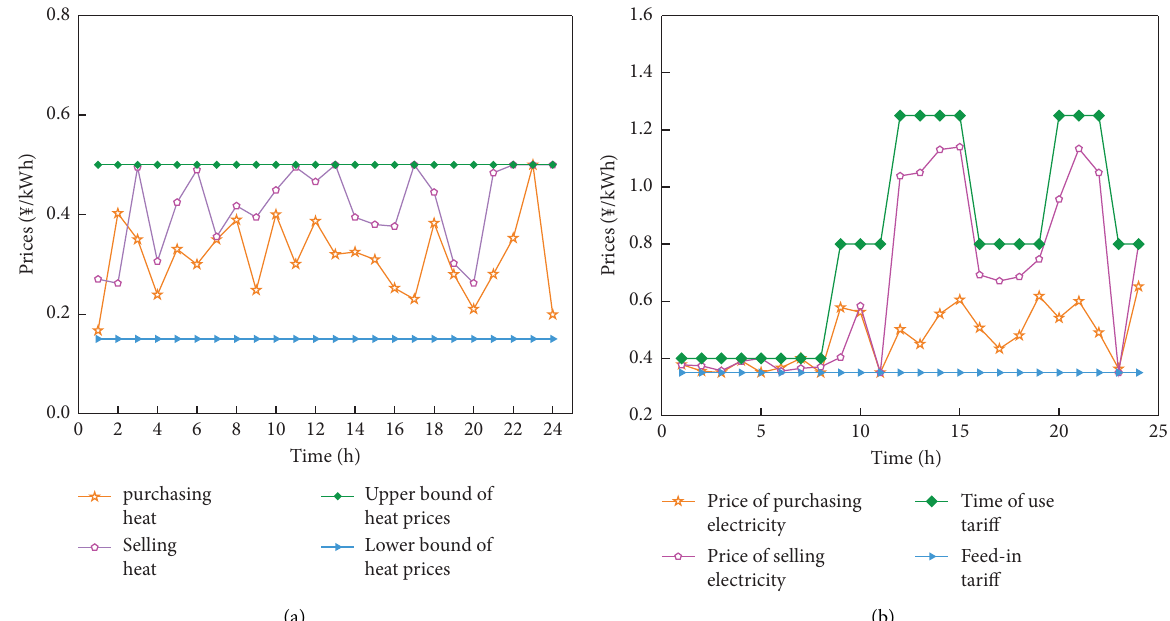
Figure 9: Energy prices of the ESO. (a) Te curve of heat price. (b) Te curve of electricity